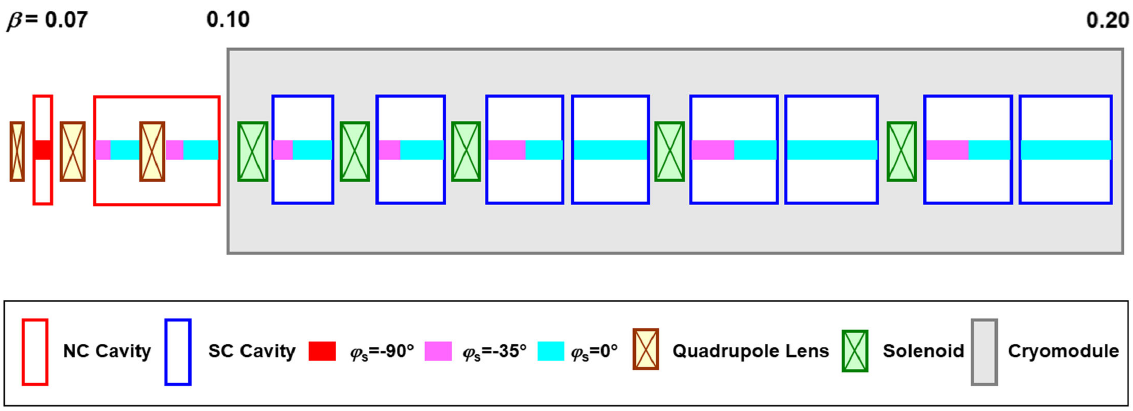
FIG. 6. Schematic layout of the ∼ 12 -m-long 6 MW